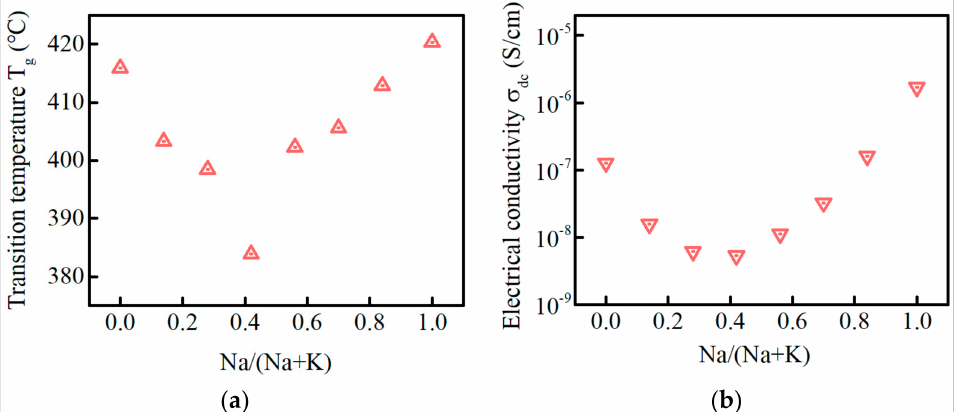
Figure 2. ( a ) Glass transition temperature (T g ) and ( b ) DC conductivity ( σ dc ) of the PKNi glass at 237 ◦ C, with different Na/(Na+K)